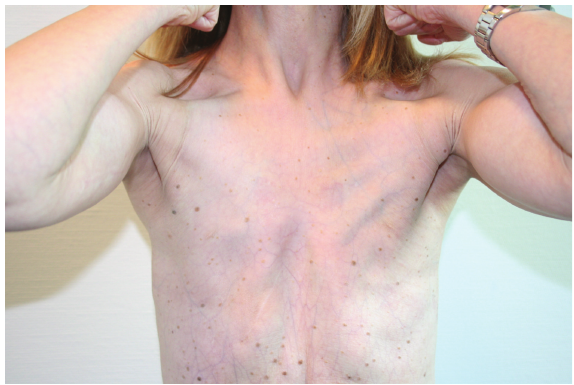
Figure 2: Preoperative view. Note thin skin with visible superficial vascular weave and hypofunction of pectoralis